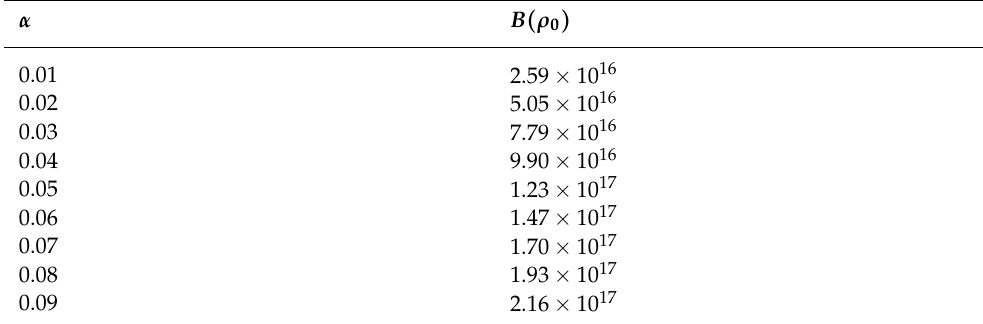
Figure 3. B( ρ ) as a function of baryon number density ρ for various γ parameters with B 0 = 2.5 × 10 18 G and α = 0.05. The colored lines represent the following: black (solid line), magnetic fields B ( ρ ) with γ = 1; purple (solid line), magnetic fields B ( ρ ) with γ = 2; green (solid line), magnetic fields B ( ρ ) with γ = 3; light blue (solid line), magnetic fields B ( ρ ) with γ = 4; orange (solid line), magnetic fields B ( ρ ) with γ = 5; yellow (solid line), magnetic fields B ( ρ ) with γ = 6; dark blue (solid line), magnetic fields B ( ρ ) with γ = 7; red (solid line), magnetic fields B ( ρ ) with γ = 8; purple (dashed line), magnetic fields B ( ρ ) with γ = 9; brown (solid line), magnetic fields B ( ρ ) with γ = 10. Table 4. Strengths of the magnetic field at saturation density ρ 0 = 0.153 fm − 3 ( B ( ρ 0 ) in unit of Gauss) for 12 EoSs with B 0 = 2.5 × 10 18